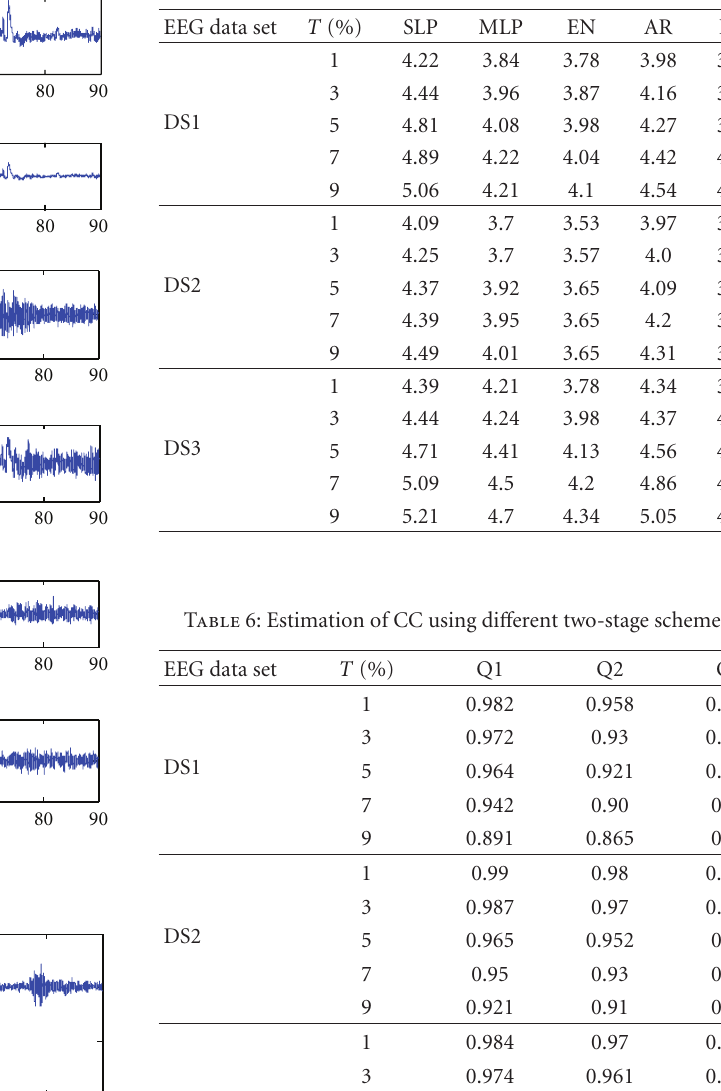
Table 5: Values of CR obtained at Q3.